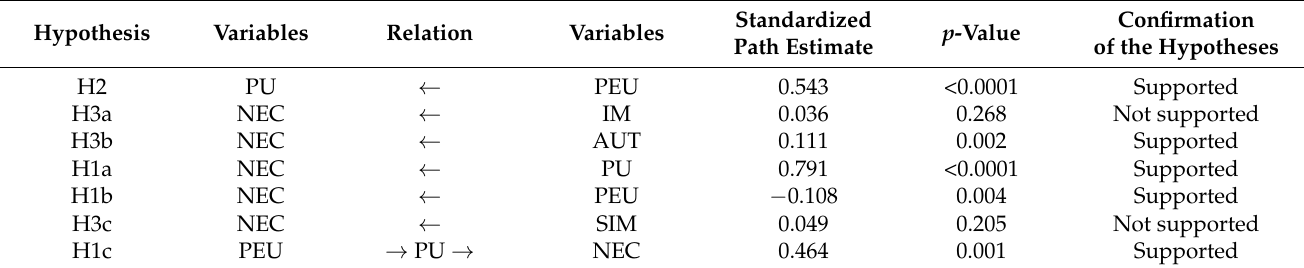
Table 8. Standardized regression weights for the structural